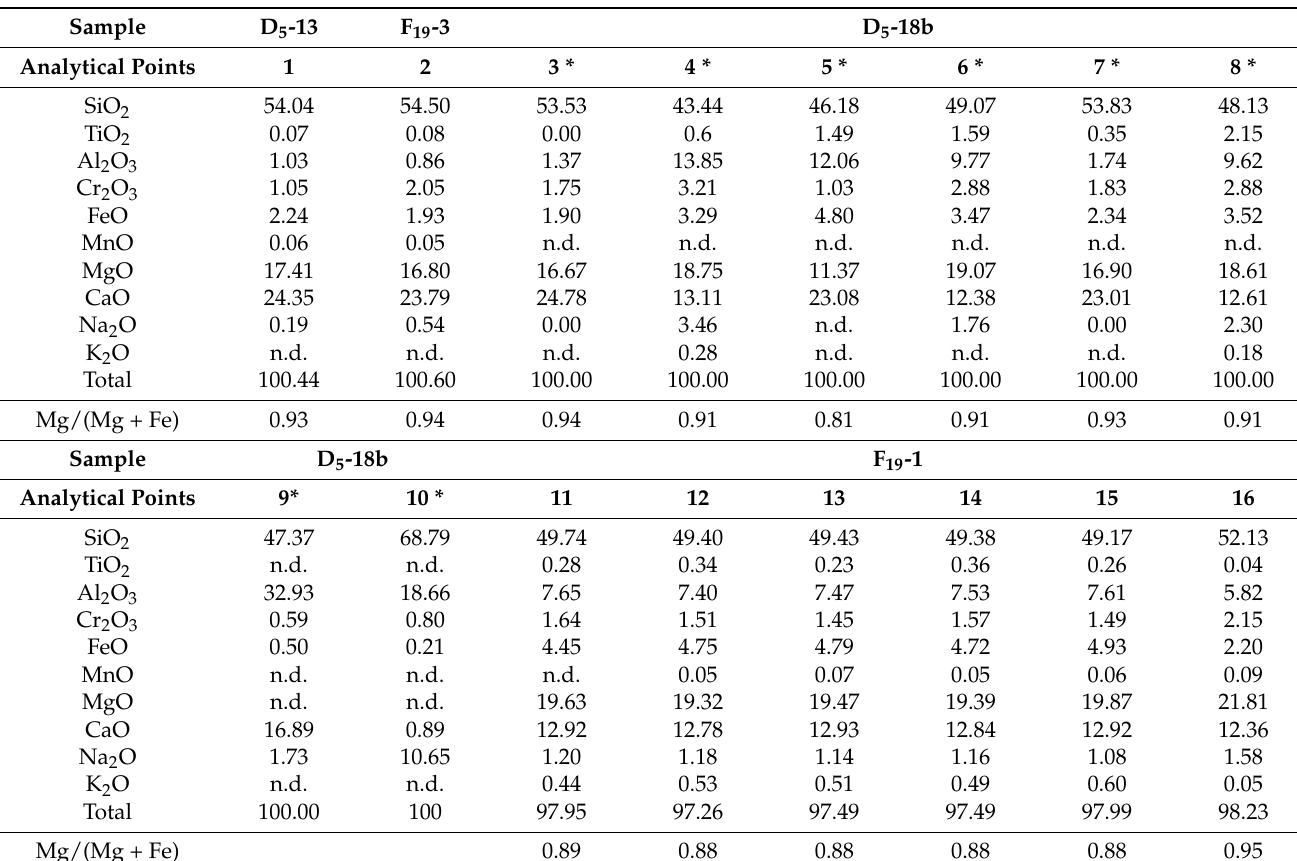
Table 4. The composition of monomineralic and polymineralic clinopyroxene–amphibole–plagioclase inclusions in chromite